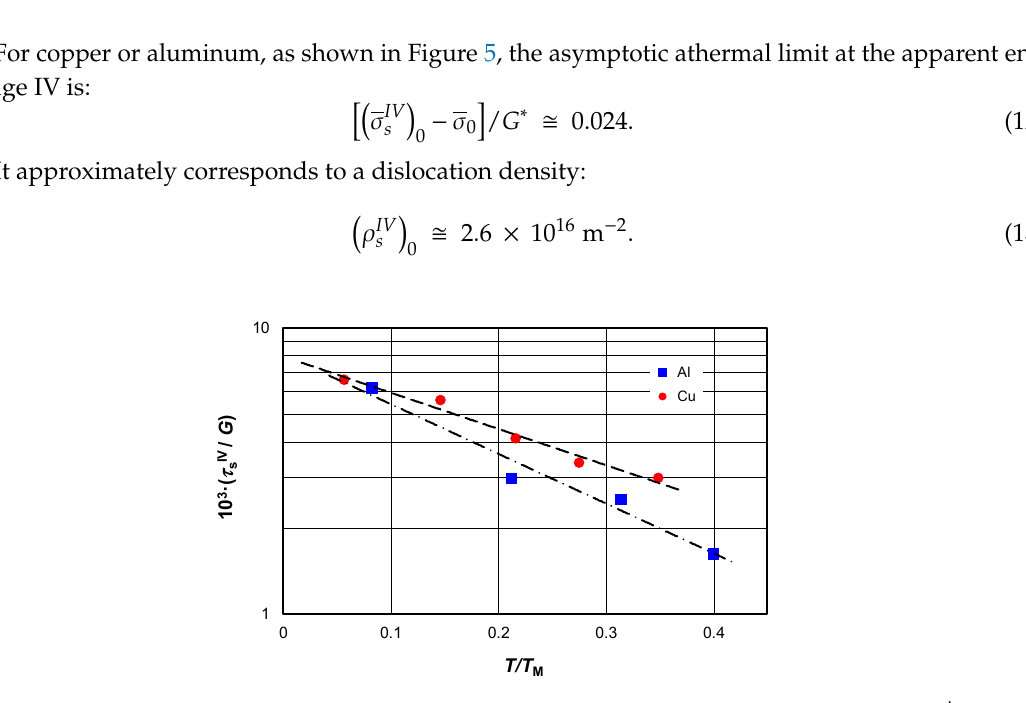
Figure 5. Normalized crystallographic slip shear flow stress (from torsion tests, VME strain rate (cid:2013)̅(cid:4662) = 8 × 10 − 3 s − 1 ) at the (apparent) saturation of Stage IV of commercial purity copper and aluminum as a function of homologous test temperature. The athermal limit is about 0.008 G *. Using an orientation factor M = 3, the VME athermal saturation flow stress for these two face-centered cubic (fcc) metals would be 0.024 G *. Data from Alberdi [11].